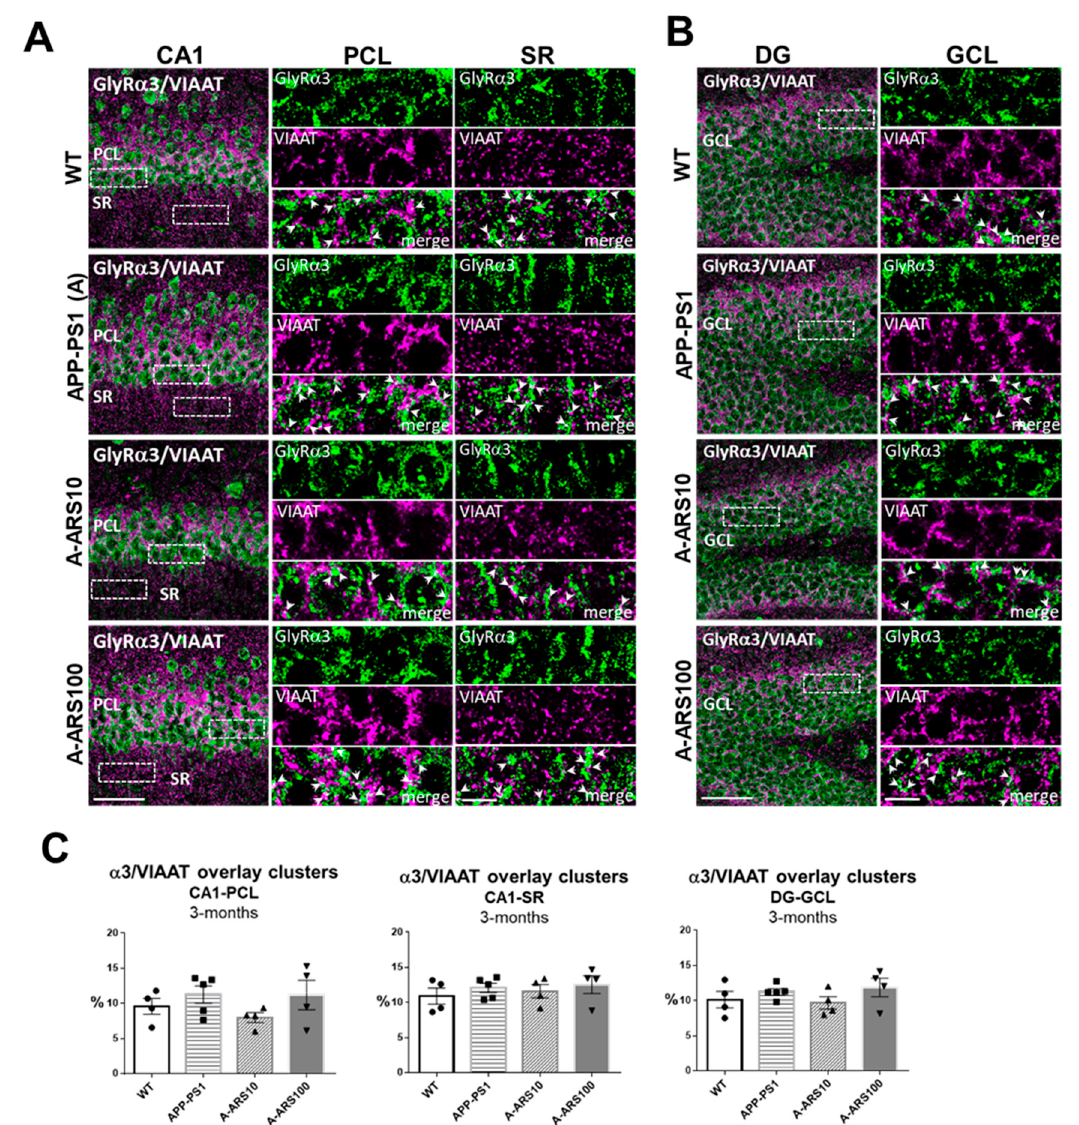
Figure 3. Subcellular localization of GlyR α 3 clusters in hippocampus sections of 3-month-old WT and APP/PS1 mice. ( A , B ) Representative double channel IF images of the CA1 region ( A ) and the dentate gyrus (DG) ( B ) of WT, APP/PS1 and APP/PS1 mice treated with two different doses (10 mg/kg and 100 mg/kg) of artesunate (A-ARS10, A-ARS100). Brain cryosections were double labeled with an anti-GlyR α 3 (green) and an anti-VIAAT (magenta) antibody. Right rectangular panels are magnifications of the boxed windows within the pyramidal cell layer (PCL) and the stratum radiatum (SR) of the CA1 region and granule cell layer (GCL) of DG, respectively, showing single channel acquisitions (GlyR α 3, VIAAT) and merged images. Arrows in merged images point to overlapping puncta, indicating putative synaptic localized GlyR α 3 clusters. Confocal maximum intensity projections (8 optical sections, 3.5-µm thick z-stack; rectangular panels—2 optical sections, 1-µm thick z-stack); Scale bars: 50 µm; panels: 10 µm. ( C ) Quantitative analyses of overlay clusters in hippocampus areas. Note the lower density of GlyR α 3 positive/VIAAT positive clusters in the PCL of low-dose artesunate-treated APP/PS1 mice in comparison to untreated ones. Three randomly chosen fields within PCL and SR of CA1 and two in the dentate gyrus (DG) of each hippocampus were analyzed ( n = 4–5 brains/group). The numbers of overlapping clusters were normalized to the total number of clusters positive for GlyR α 3 subunit and given as a percent (%). Means ± SEM. In summary, our analyses of 3-month-old mice demonstrate that in APP/PS1 mice, the protein levels of GlyR α 2 and α 3 subtypes are not changed compared to age-matched